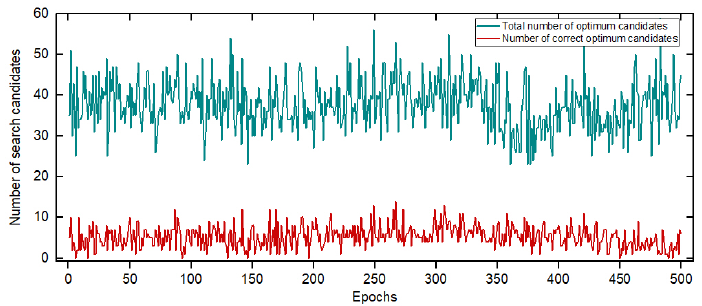
Figure 11. Number of optimum candidates searched in x , y , z